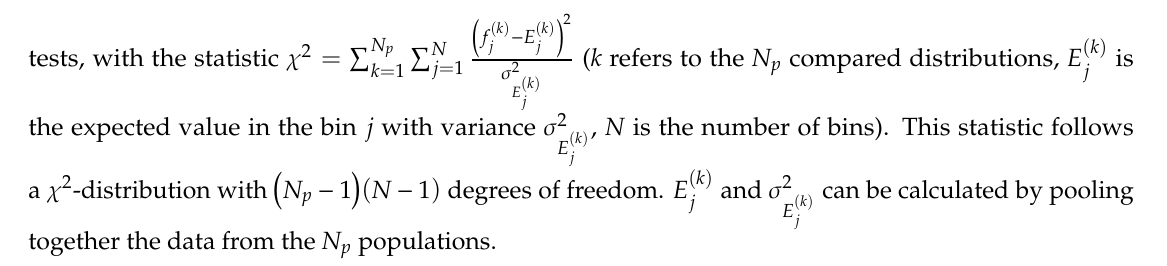
Figure S1: Confocal images showing F-actin stained with Alexa Fluor ™ 647 Phalloidin, Table S1: Average values of size, D m , α and α at short times ( α short) extracted from i MSD analysis of lysosomes during NSCs di ff erentiation, Table S2: Statistical data for Figure